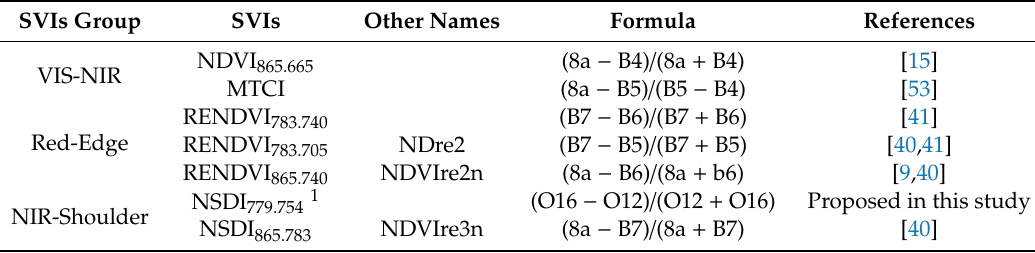
Figure 2. VIS-NIR, RE and NIR-shoulder (yellow, green and blue boxes, respectively) band combinations used to calculate normalized di ff erence spectral vegetation indices (NDIs). “NDI = (B1-B2) / (B1 + B2)” represents the general formula for calculating NDIs, where B1 and B2 refer to reflectance at two di ff erent bands. Table 2. SVIs based on S-2 and S-3